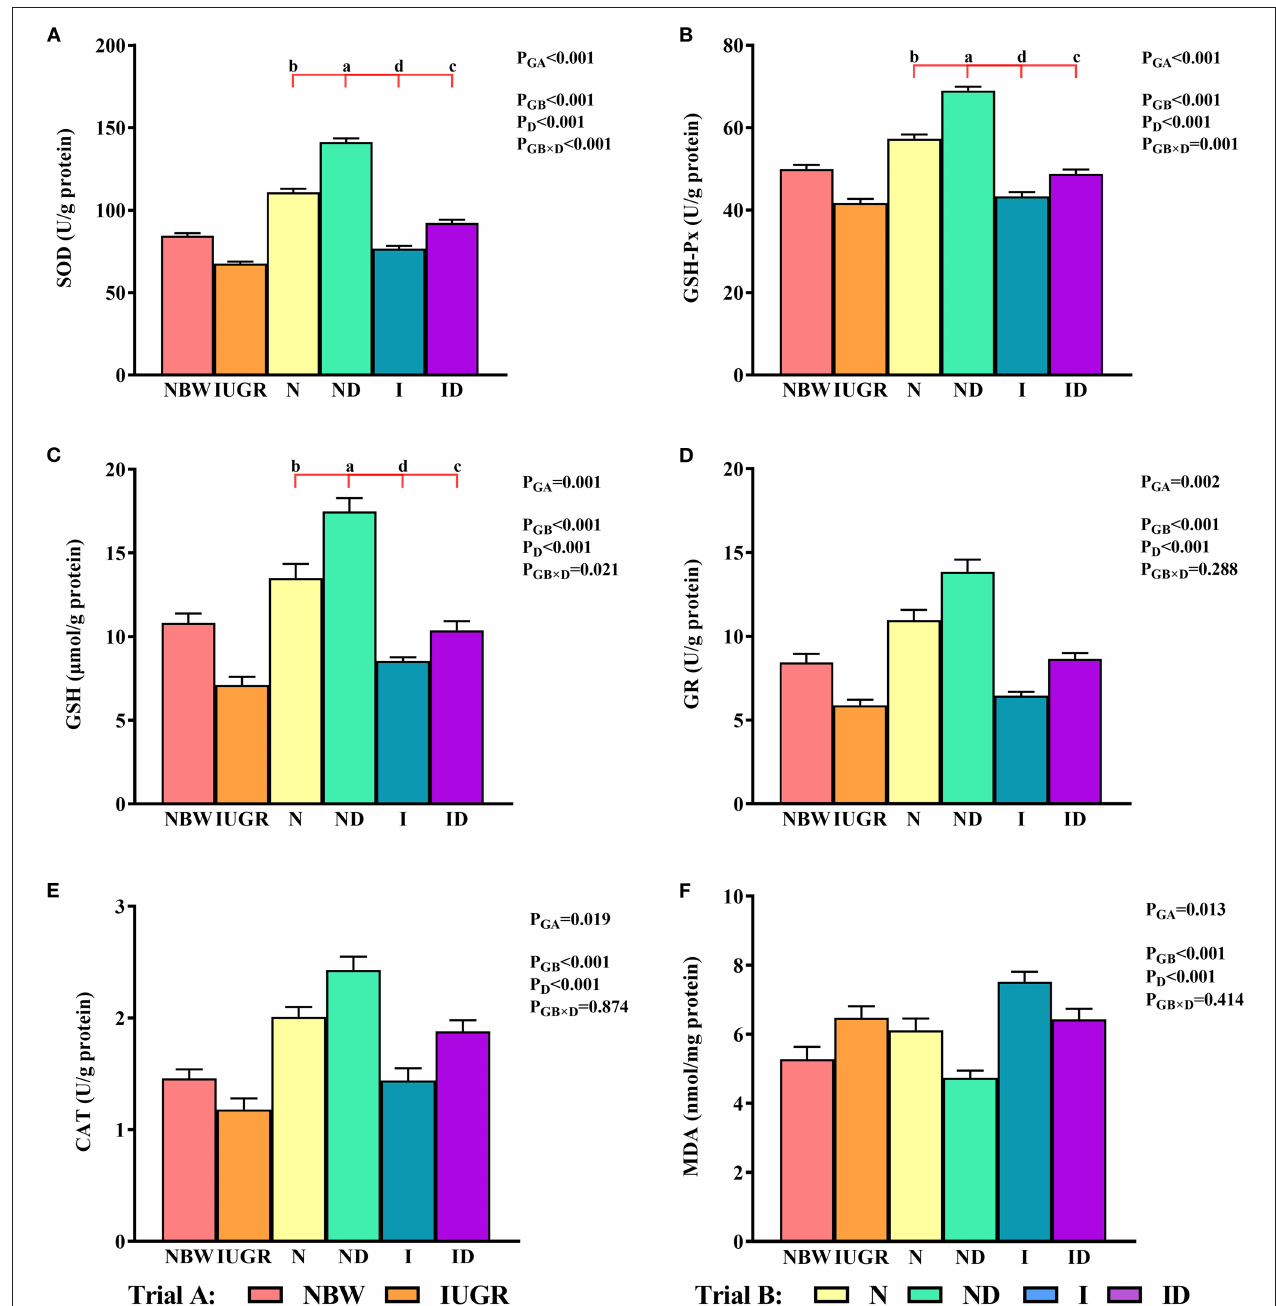
FIGURE 3 | (A–F) Supplementation with DMG-Na improved the hepatic redox status of IUGR suckling piglets. Data are expressed as the mean ± SD; n = 10 suckling piglets per group. The P -value (trial A: NBW, IUGR group in black color) and a, b, c, d (trial B: N, ND, I, ID group in red color) represent significant differences ( P < 0.05). NBW, normal birth weight newborns; IUGR, intrauterine growth restriction newborns; N, NBW newborns fed a basic milk diet; ND, NBW newborns fed a basic milk diet plus 0.1% DMG-Na; I, IUGR newborns fed a basic milk diet; ID, IUGR newborns fed a basic milk diet plus 0.1% DMG-Na. SOD, superoxide dismutase; GSH-Px, glutathione peroxidase; GSH, glutathione; GR, glutathione reductase; CAT, catalase; MDA, methane dicarboxylic aldehyde.